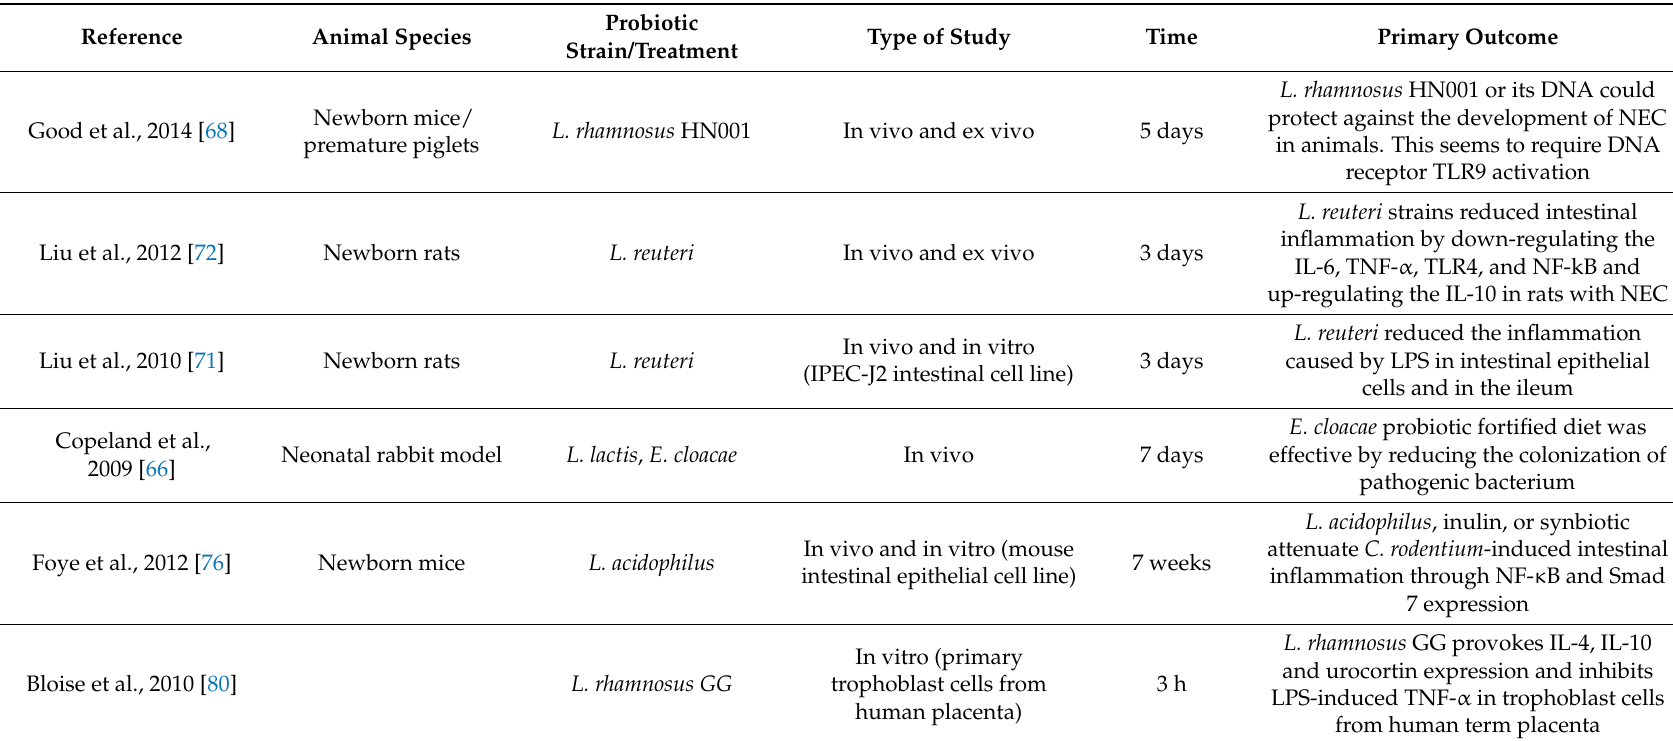
Table 2. General probiotic mechanisms of action in